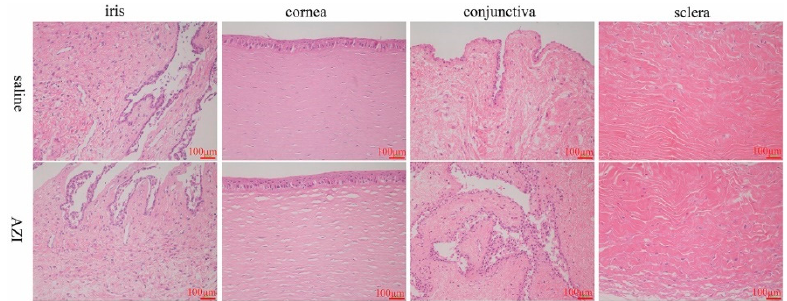
Figure 6. Evaluation of eye irritation by histopathological examinations of iris, cornea, conjunctiva and sclera.